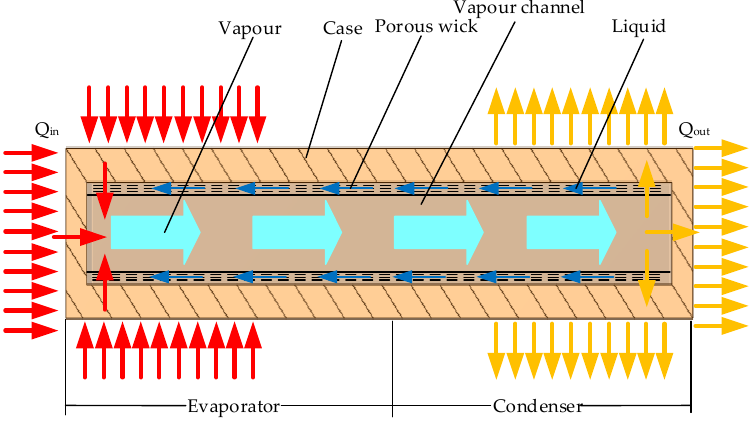
Figure 4. The principle of the heat pipe.